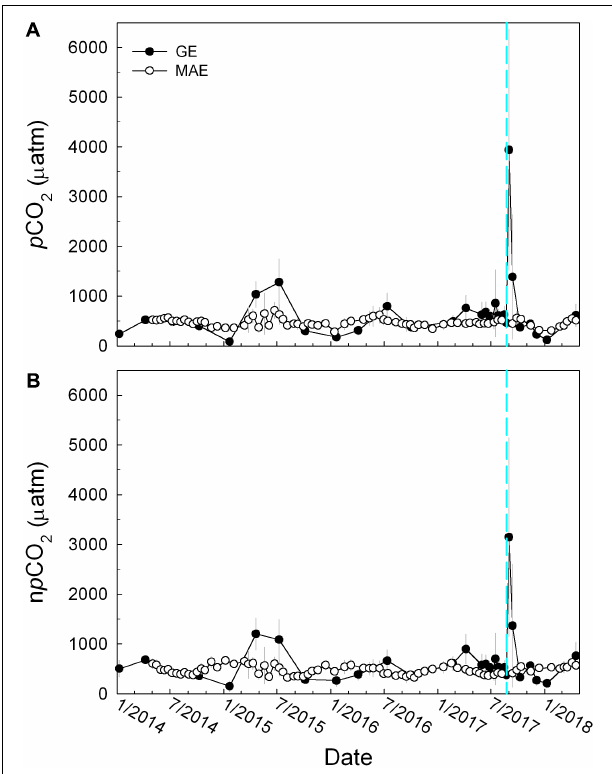
FIGURE 4 | Temporal distributions of (A) in situ p CO 2 and (B) temperature normalized p CO 2 (n p CO 2 ) in MAE (open circles) and GE (closed circles), see text for the temperatures that data from these two estuaries were normalized to. The gray vertical lines represent standard deviation of the mean.